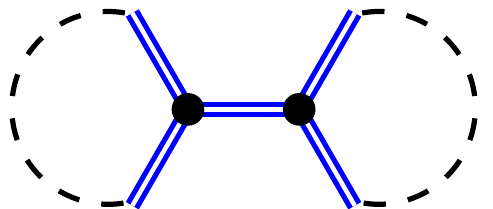
Figure 5: Tree-level graviton-graviton scattering diagram. The dashed lines indicate the transverse-traceless contraction of the external